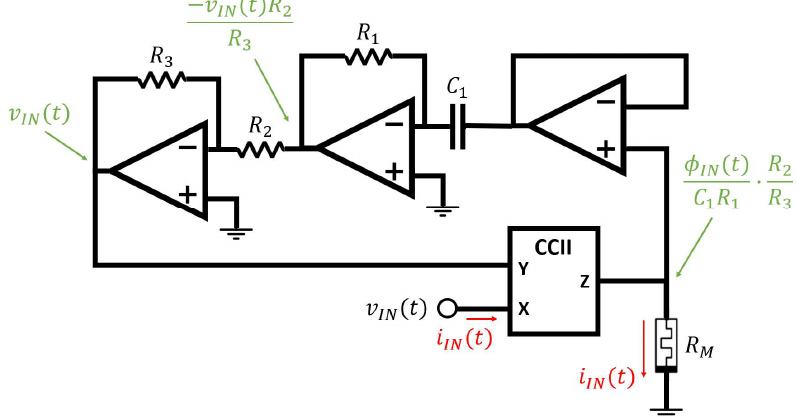
Figure 12. Meminductor emulator circuit proposed by Sah et al. [51].